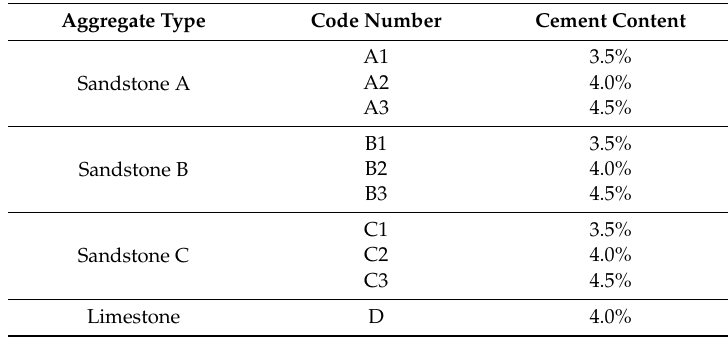
Table 3. The cement content.